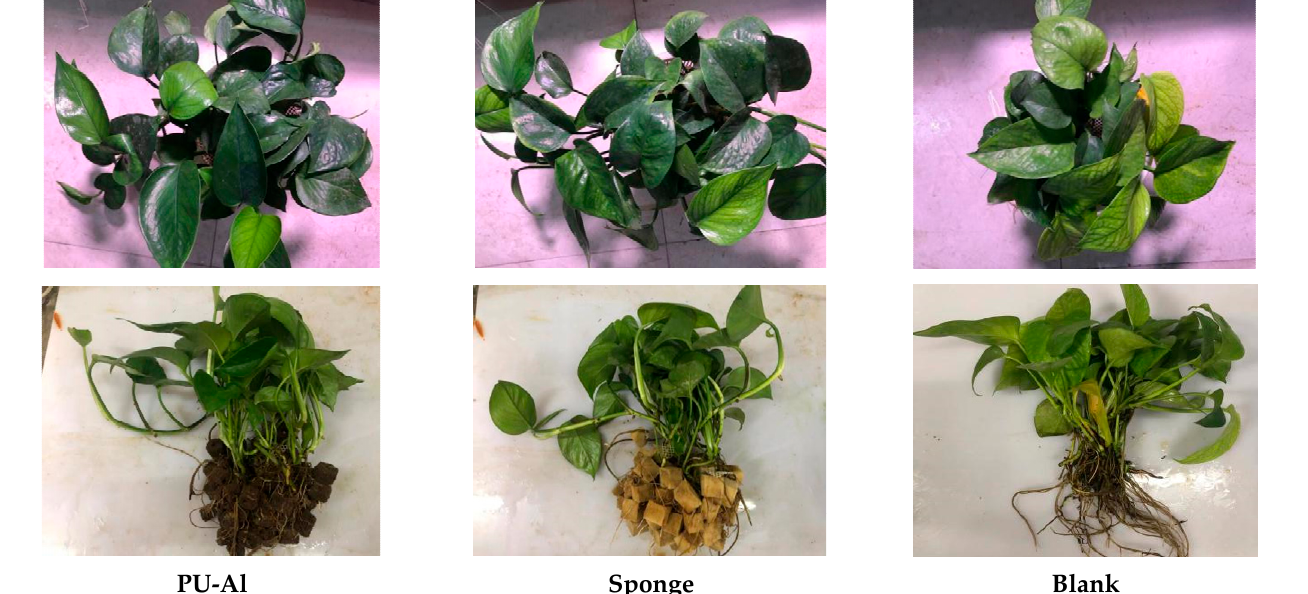
Figure 7. Comparison of plants’ growth states in three FTWs.